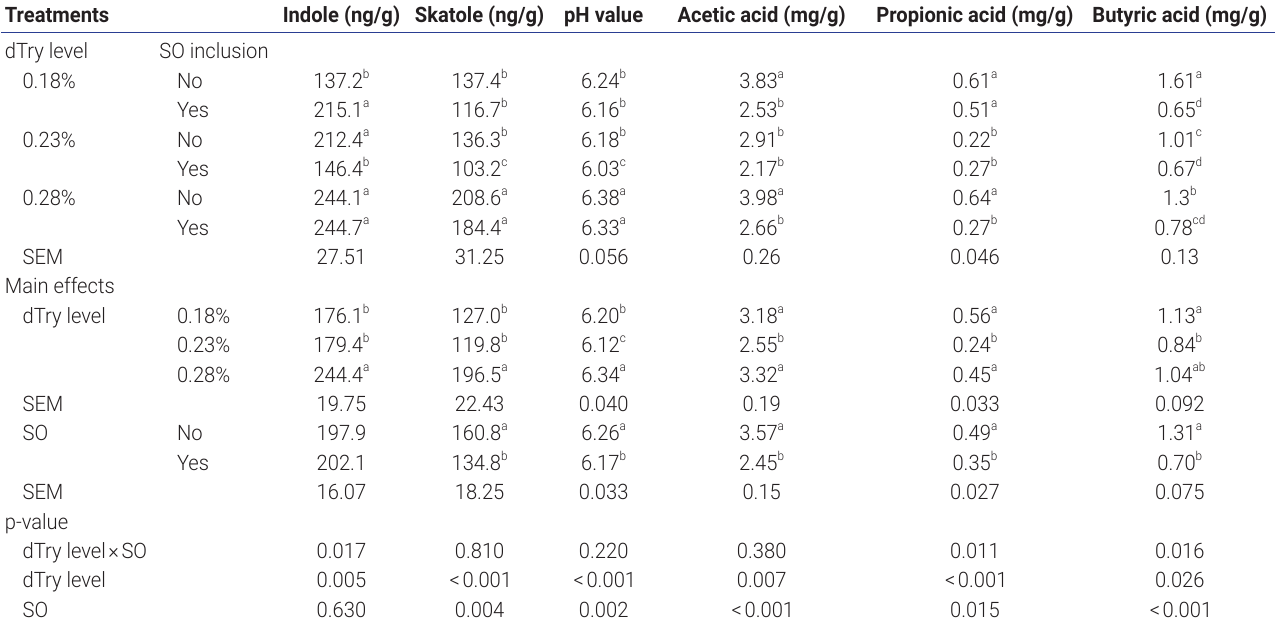
Table 3. Effects of dietary digestible tryptophan (dTry) and soy oligossacharide (SO) supplementation on levels of skatole, indole, volatile fatty ac- ids, and pH value in caecal contents of broiler chickens